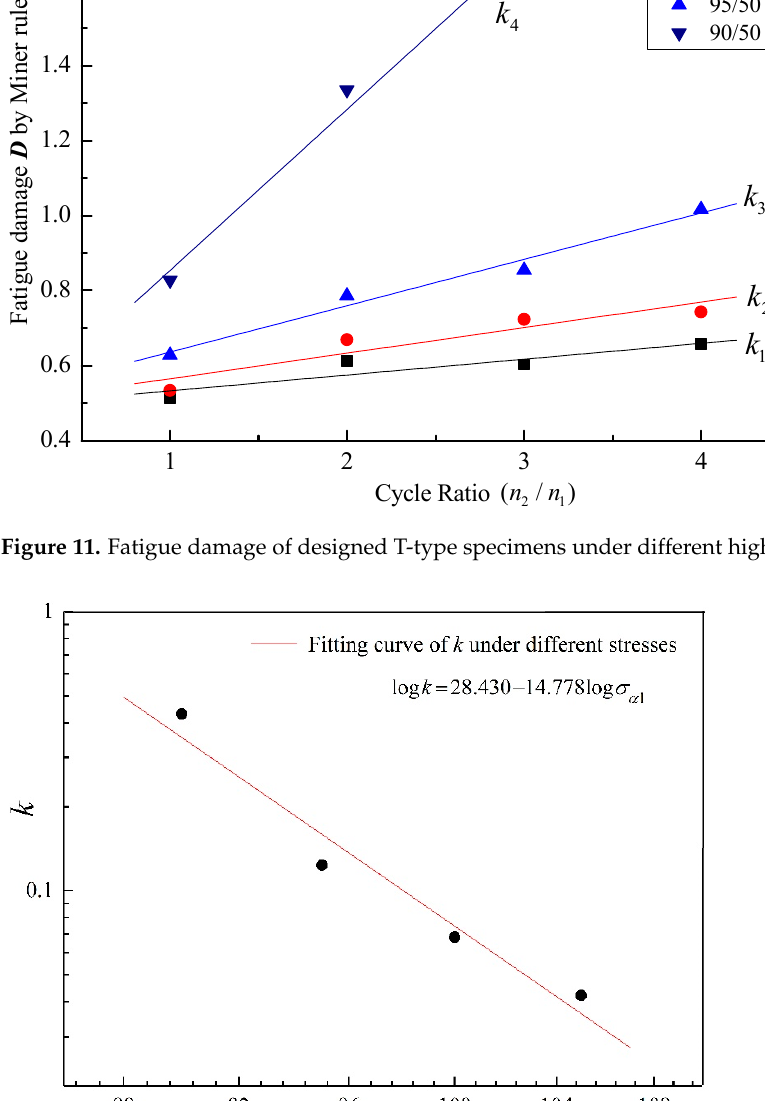
Figure 12. Double logarithmic curve between the high stress and slope k .